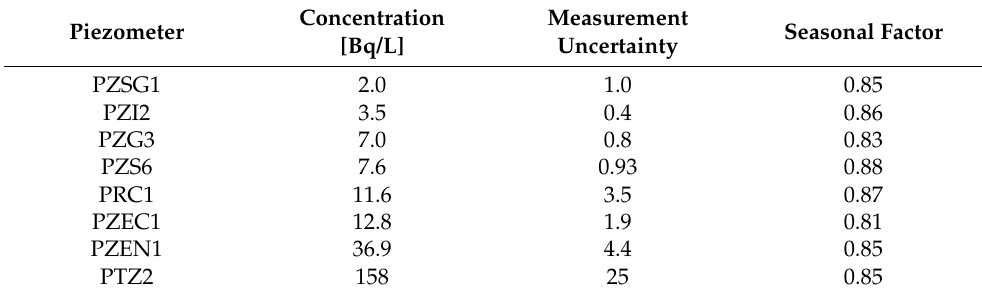
Table 4. Concentration Values of Radon Volumetric Activity (Median Values) [6].